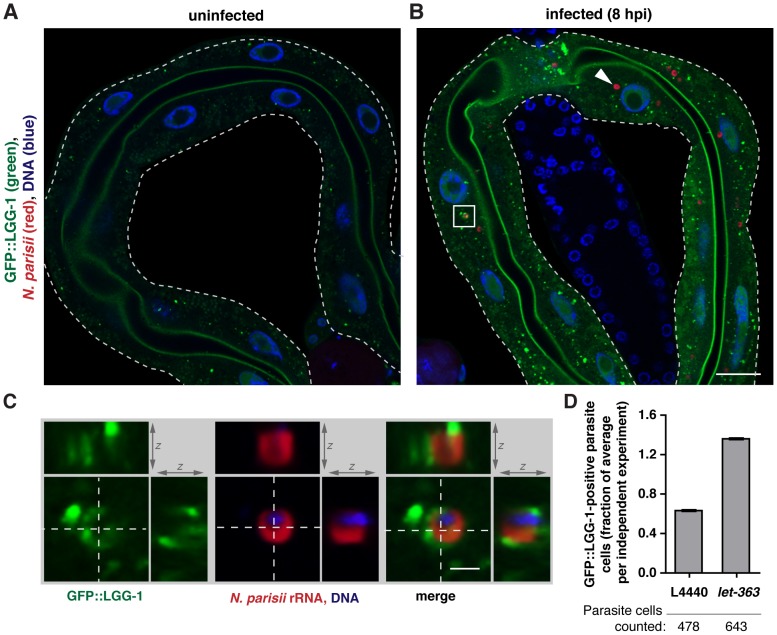
Targeting of N. parisii cells by the autophagy marker GFP::LGG-1 increases upon let-363/TOR RNAi.GFP::LGG-1-expressing transgenic animals were fixed and stained with a FISH probe against N. parisii rRNA (red) and DAPI for DNA (blue). A) Intestine of an uninfected nematode, and B) an N. parisii-infected nematode, 8 hpi, are shown. N. parisii parasite cells not colocalizing with GFP::LGG-1 (arrowhead) and surrounded by GFP::LGG-1 (boxed in area) are indicated. Scale bars  = 20 µm. C) Enlarged view of boxed in area from panel B, showing cross-section from two other dimensions. Scale bar  = 2 µm. D) Quantification of parasite cell colocalization at 8 hpi with wild-type GFP::LGG-1 following knockdown of let-363 compared to L4440 vector control. Data are normalized for the average level of targeting in each independent experiment. Mean +/− SEM of two independent experiments is shown. Number of individual parasite cells assessed for colocalization is indicated.